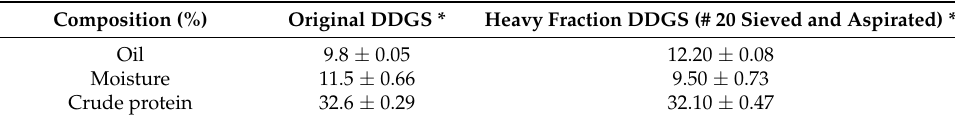
Table 1. Oil, moisture, and crude protein content of original and heavy fraction